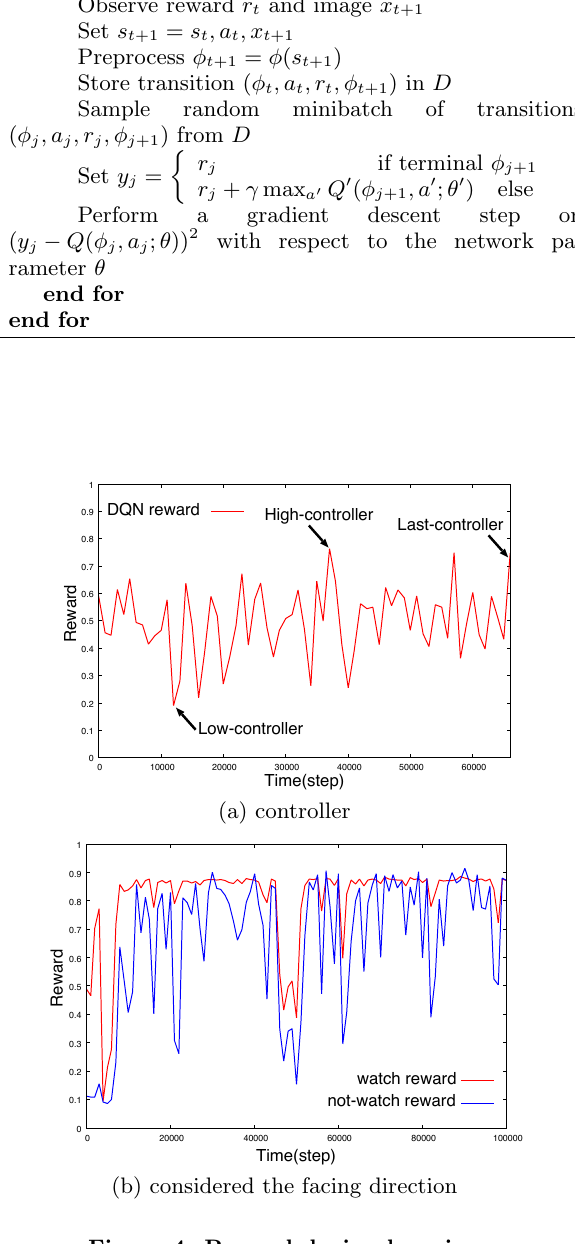
Figure 4: Reward during